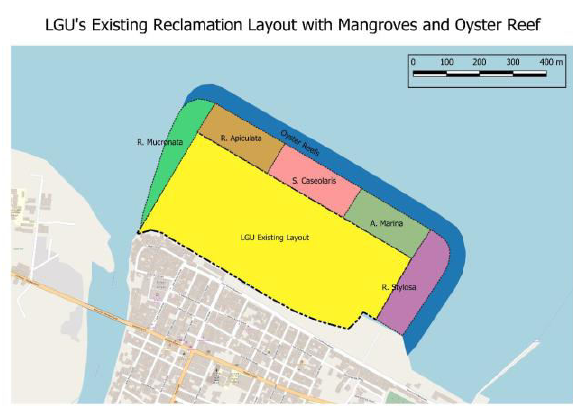
Figure 8 . LGU reclamation plan. Yellow zone is for government, commercial and recreational use, blue zone is for oyster reefs, while the remaining zones are for different species of